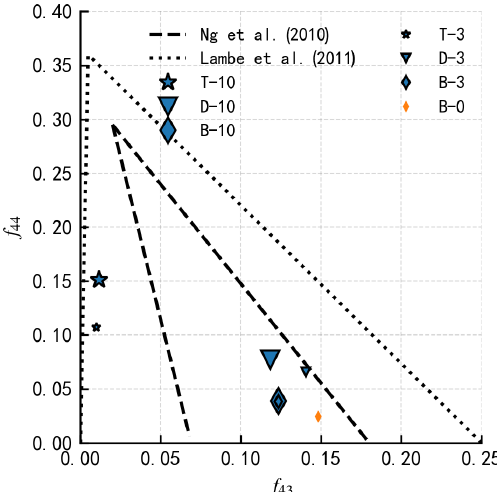
Figure B2. The measured fraction of AMS signals at m/z = 43 ( f 43 ) and m/z = 44 ( f 44 ). SOA generated from n -dodecane and β - caryophyllene in this study are within the ambient SOA f 44 and f 43 range measured by Ng et al. (2010). Toluene-derived SOA in this study exhibits a similar f 44 and f 43 signal range to the laboratory measurement of glyoxal-derived SOA (Lambe et al.,